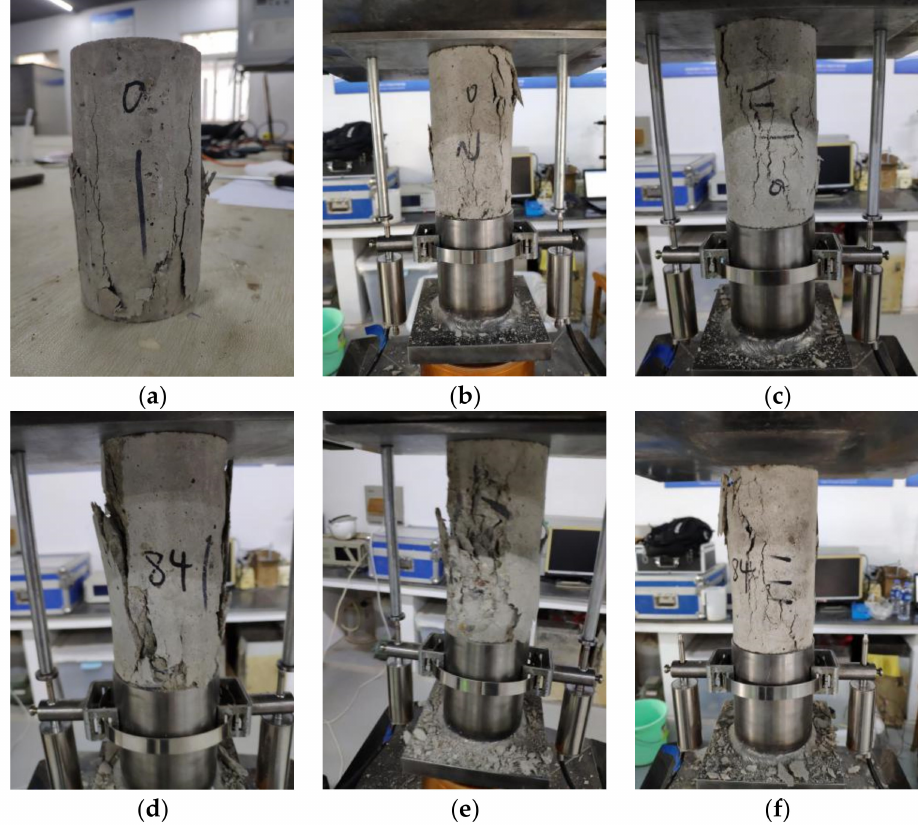
Figure 5. The failure pattern of RAC and NAC specimens. ( a ) NAC-0.0 mm; ( b ) RAC50-0.0 mm; ( c ) RAC100-0.0 mm; ( d ) NAC-19.8 mm; ( e ) RAC50-31.0 mm; and ( f ) RAC100-35.0